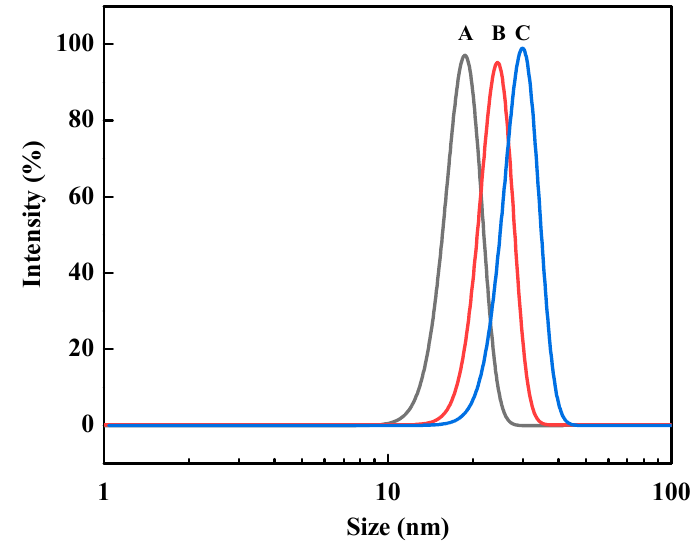
Figure 2. Size distribution of Fe 3 O 4 ( A ), Fe 3 O 4 @PDA ( B ), and Fe 3 O 4 @PDA@TLL ( C ).